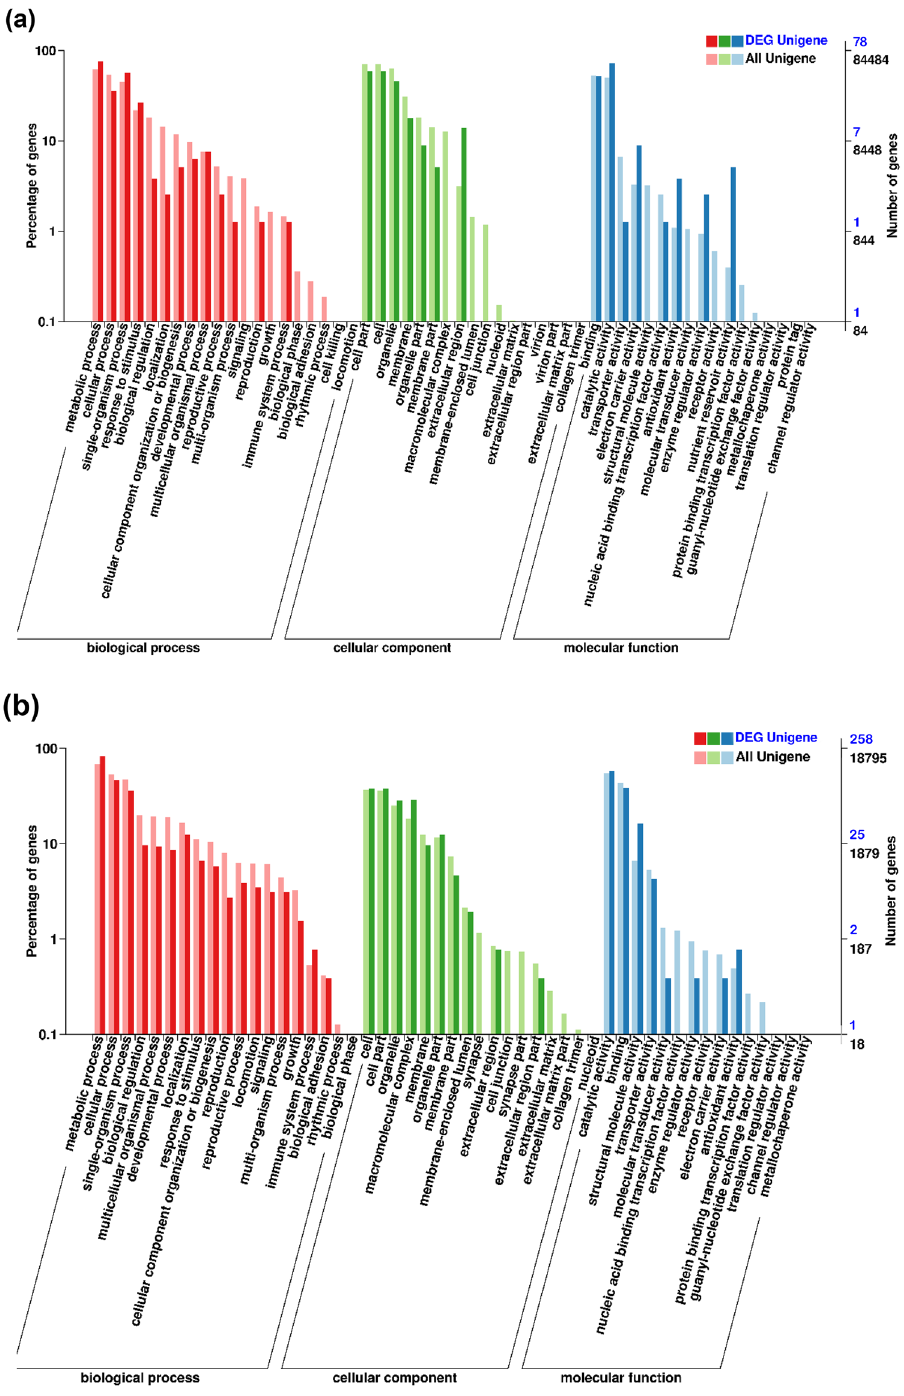
Figure 3. Gene Ontology (GO) categories of all unigenes and differentially expressed unigenes (DEG unigenes) in the wheat roots ( a ) and Heterodera avenae juveniles ( b ) in the study. The number and percentage of genes in each subcategory for the three main categories of biological process, cellular component, and molecular function are indicated for all the unigenes and DEG unigenes, respectively. On the right y-axis, blue and black numbers are DEG unigenes and all unigenes,